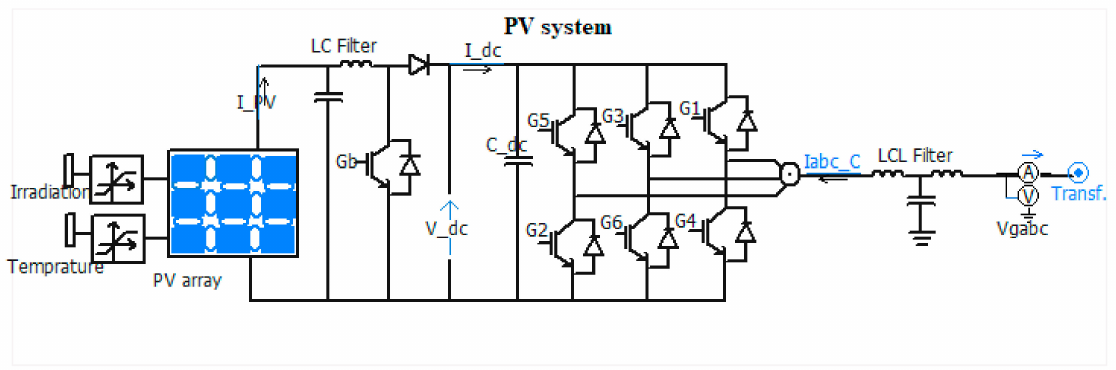
Figure 5. Detailed block diagram of PV system.